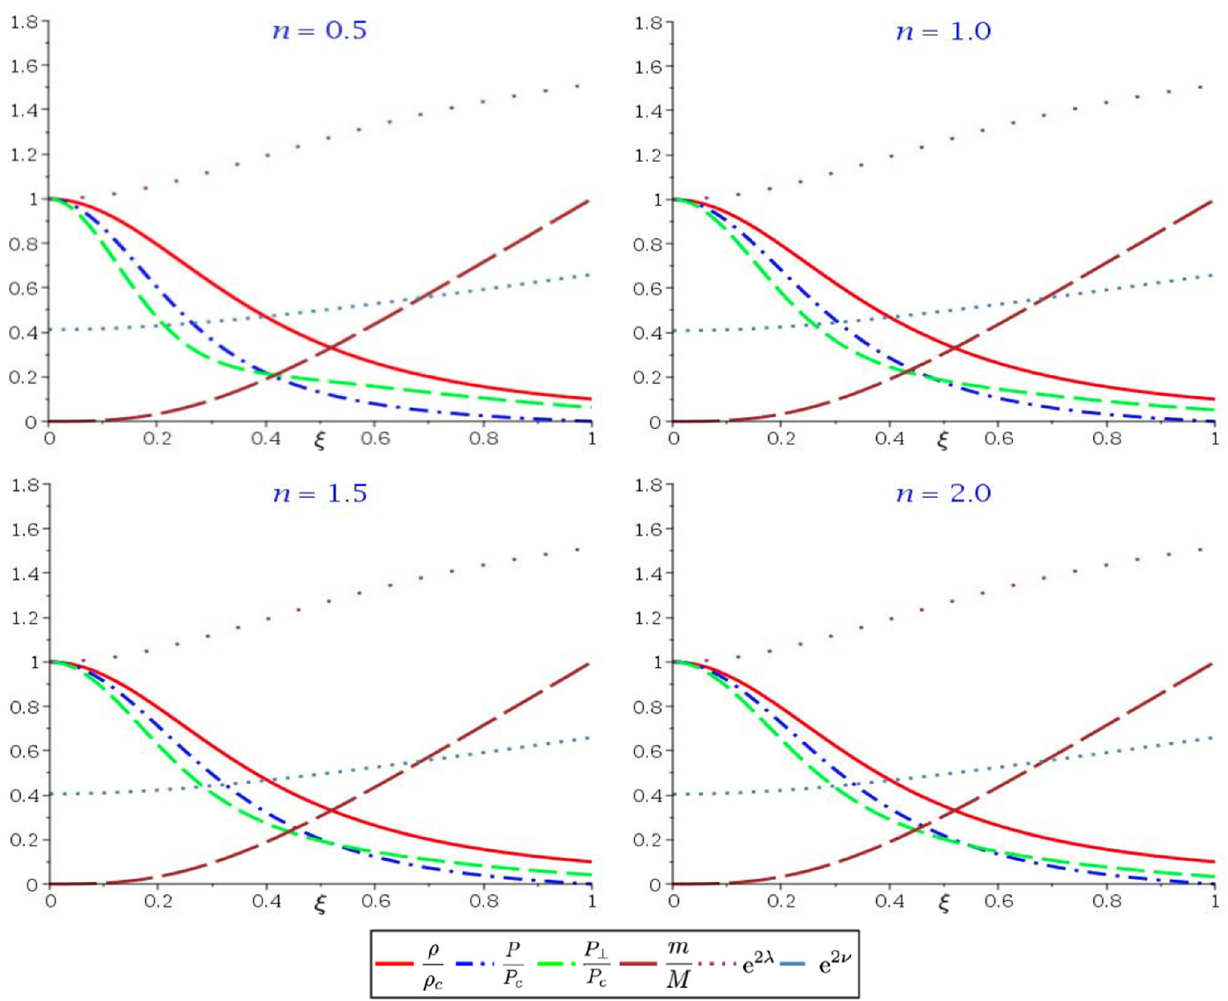
Fig. 2 Physical variables and metric functions for a matter configura- tion with EoS-2. The different plates illustrate various values of n hav- ing σ = 0 . 12. The normalised distributions of density, radial/tangential pressures, mass and the components of the metric tensor are given in